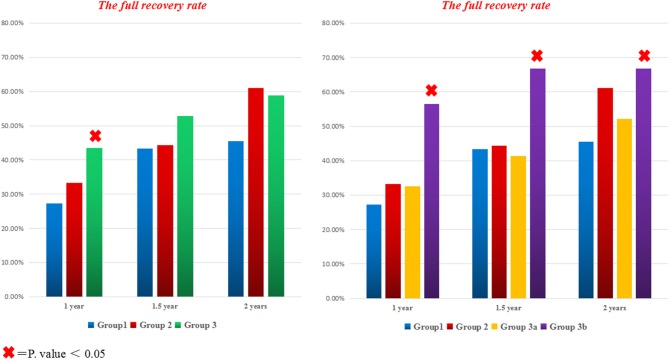
The full recovery rate for all groups at different time points. The bar graph on the left side compares the percentage of fully recovered patients with TBM in all different treatment groups; while the bar graph on the right side contrasts the full recovery rate in all groups after subdividing group3 to A (with levofloxacin) and B (with Moxifloxacin). × = P < 0.05.